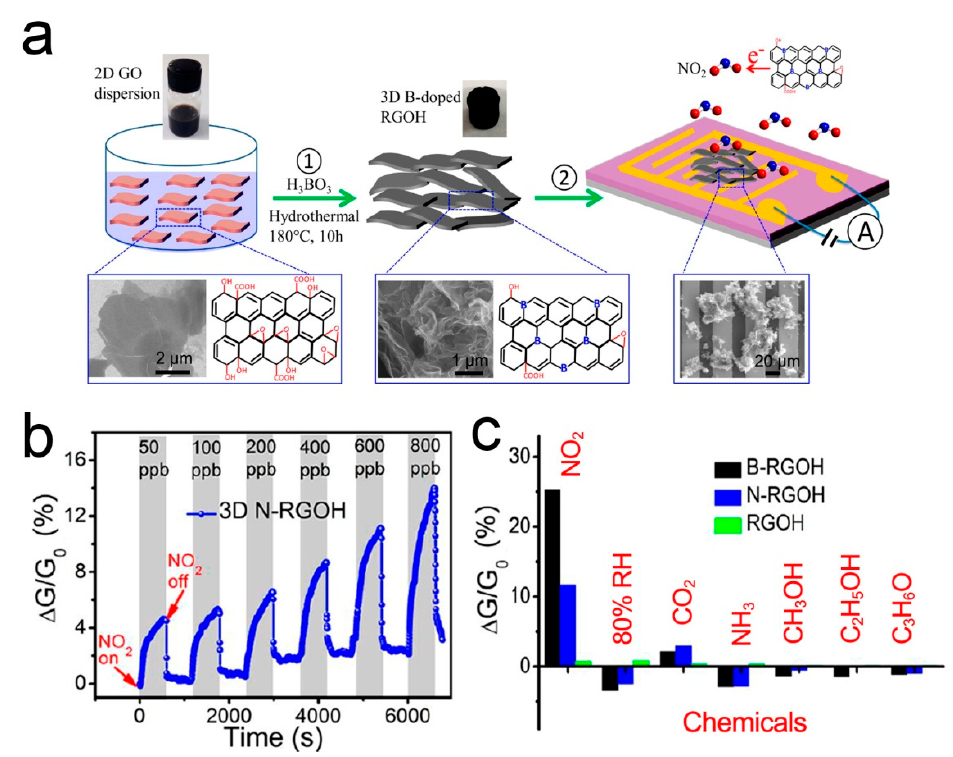
Figure 6. ( a ) Fabrication process of B-RGOH sensors. ( b ) Responses of B- and N-RGOH sensors to NO 2 . ( c ) Responses of B- and N-RGOH sensors to different vapors [87]. NO 2 . ( c ) Responses of B- and N-RGOH sensors to different vapors